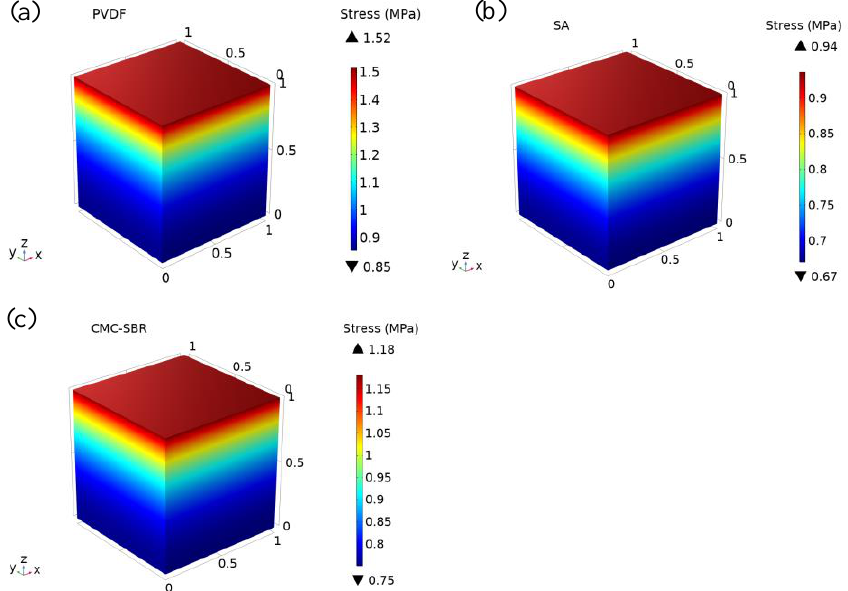
Figure 6. Internal stress distribution along with electrode coating thickness at the end of the drying process ( a )NMC/PVDF/CB; ( b )NMC/SA/CB; ( c )NMC/CMC-SBR/CB.